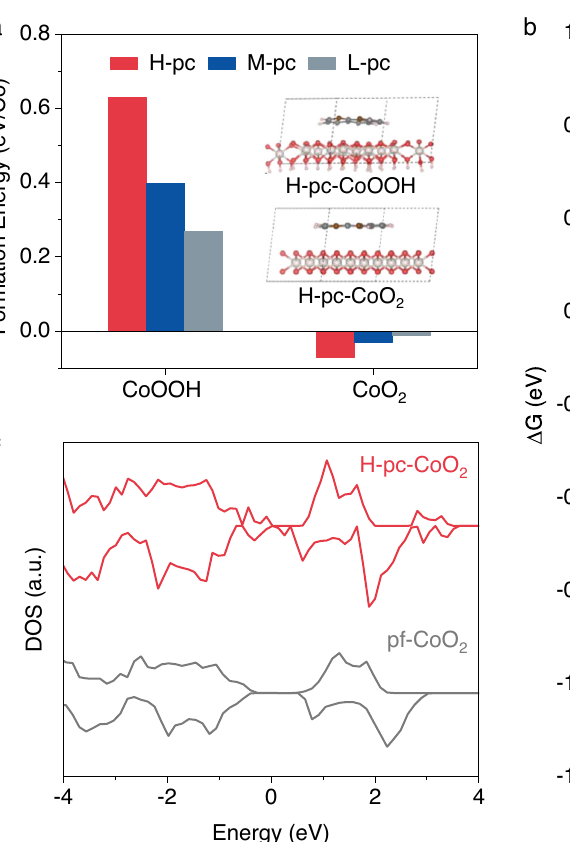
yellowish,gray,brown,red,andpinkballs,respectively. b Thefreeenergydiagrams of phen-free and H-, M-, and L- density ofphen-inserted layered CoOOH and CoO 2 . c The densities of states (DOS) of phen-free and H-density of phen-inserted CoO 2